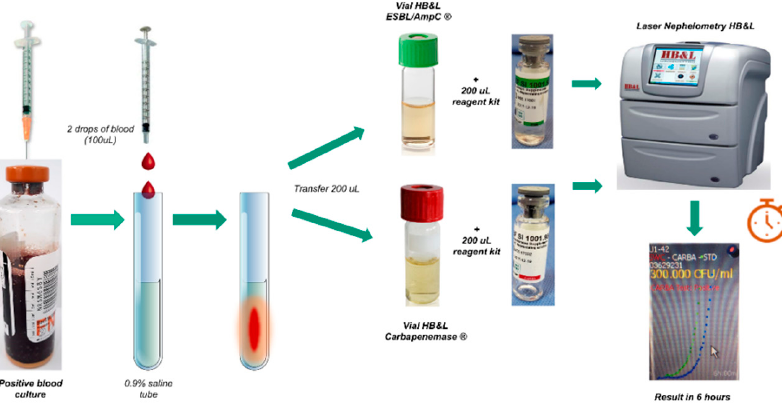
Figure 1. Processing of positive-blood-culture samples by ESBL/AMPC and HB&L Carbapenemase kit tests. Green-cap vial: vial for detecting Gram-negative bacilli with ESBL extended-spectrum beta-lactamases. Red-cap vial: vial for detecting Gram-negative bacilli carriers of carbapenemases.